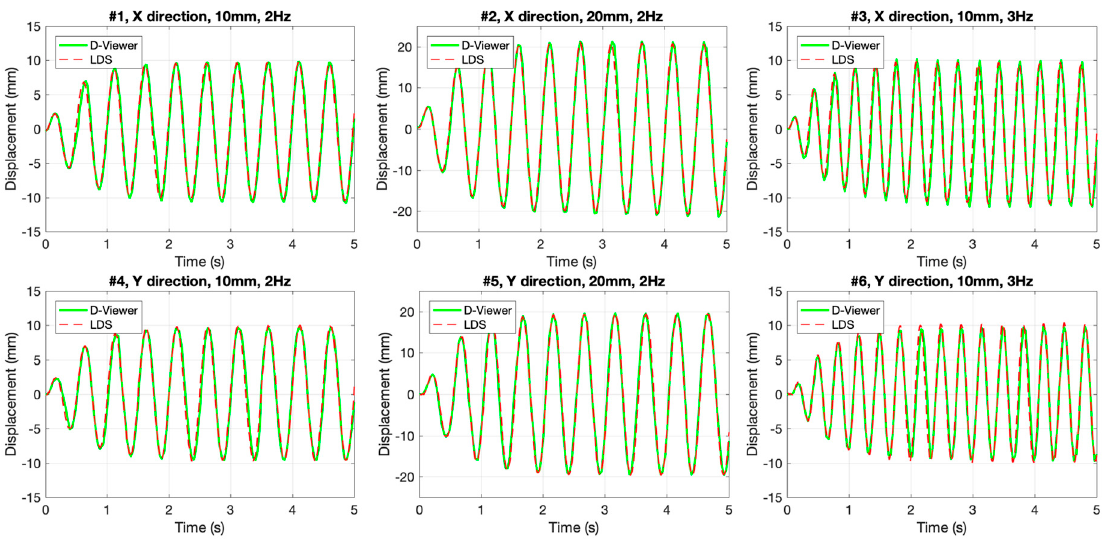
Figure A1. Experiment results of #1 to #6.